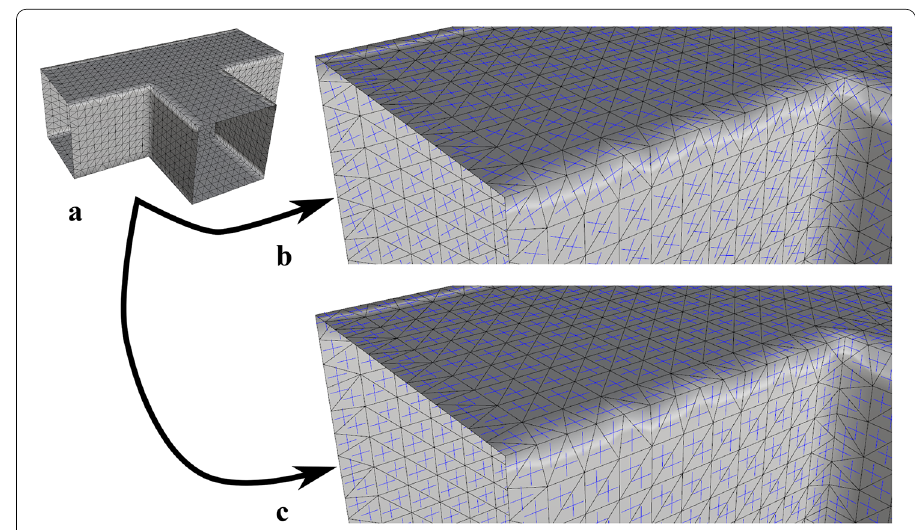
Fig. 12 Cross field generation. a Input triangulated pant with sharp features. b Topological cross field that doesn’t respect the sharp features directions. c Geometric cross field with boundaries and sharp features interpolation where the field total curvature is